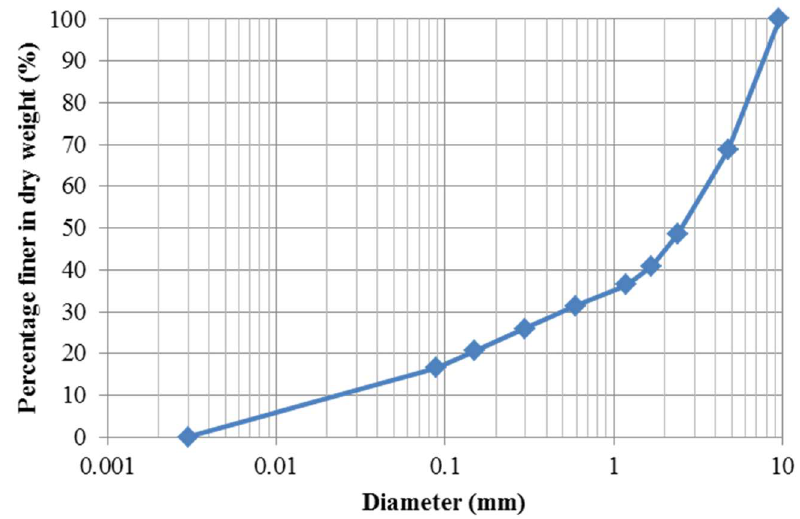
Figure 2. Grain size distribution of material. For this experiment, we used sand with particle sizes from 0.003 mm to 10 mm. We measured the distribution of the dry sand using a sieve.